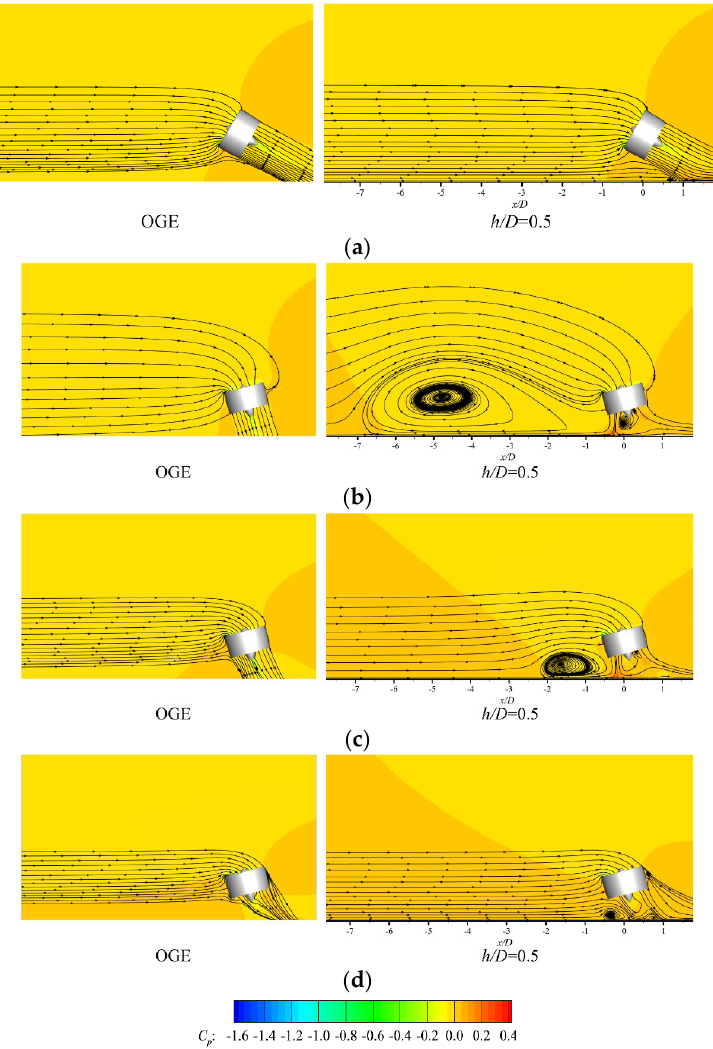
Figure 28. Pressure coefficient contour and streamlines on symmetry plane under different conditions: ( a ) J = 0.3, α = 30°; ( b ) J = 0.1, α = 75°; ( c ) J = 0.3, α = 75°; ( d ) J = 0.5, α = 75°.